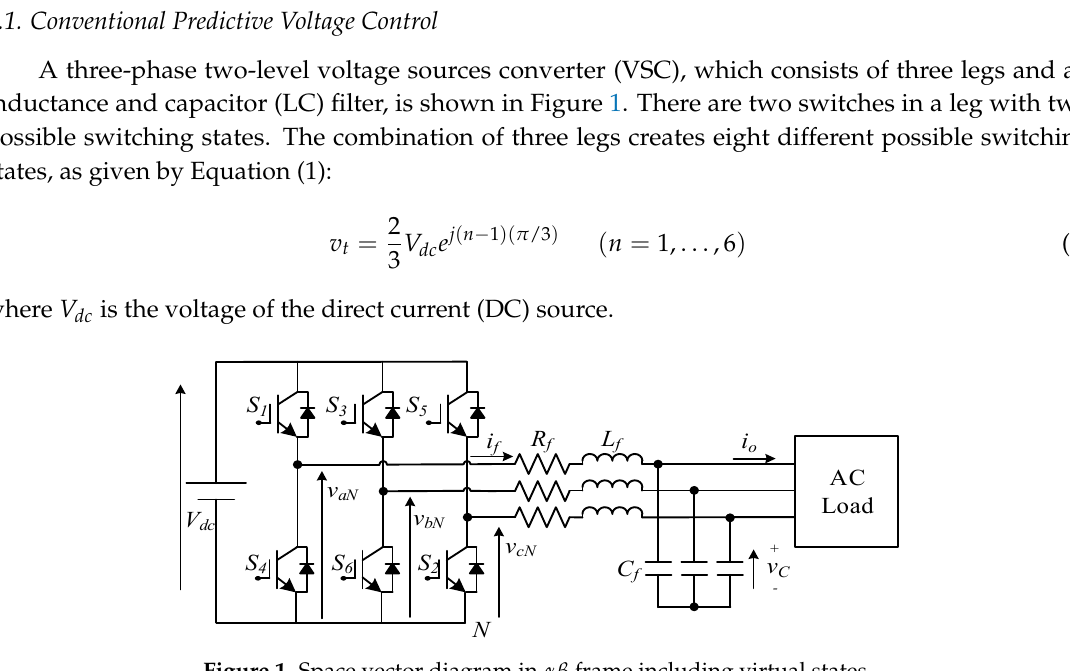
Figure 1. Space vector diagram in αβ frame including virtual states.